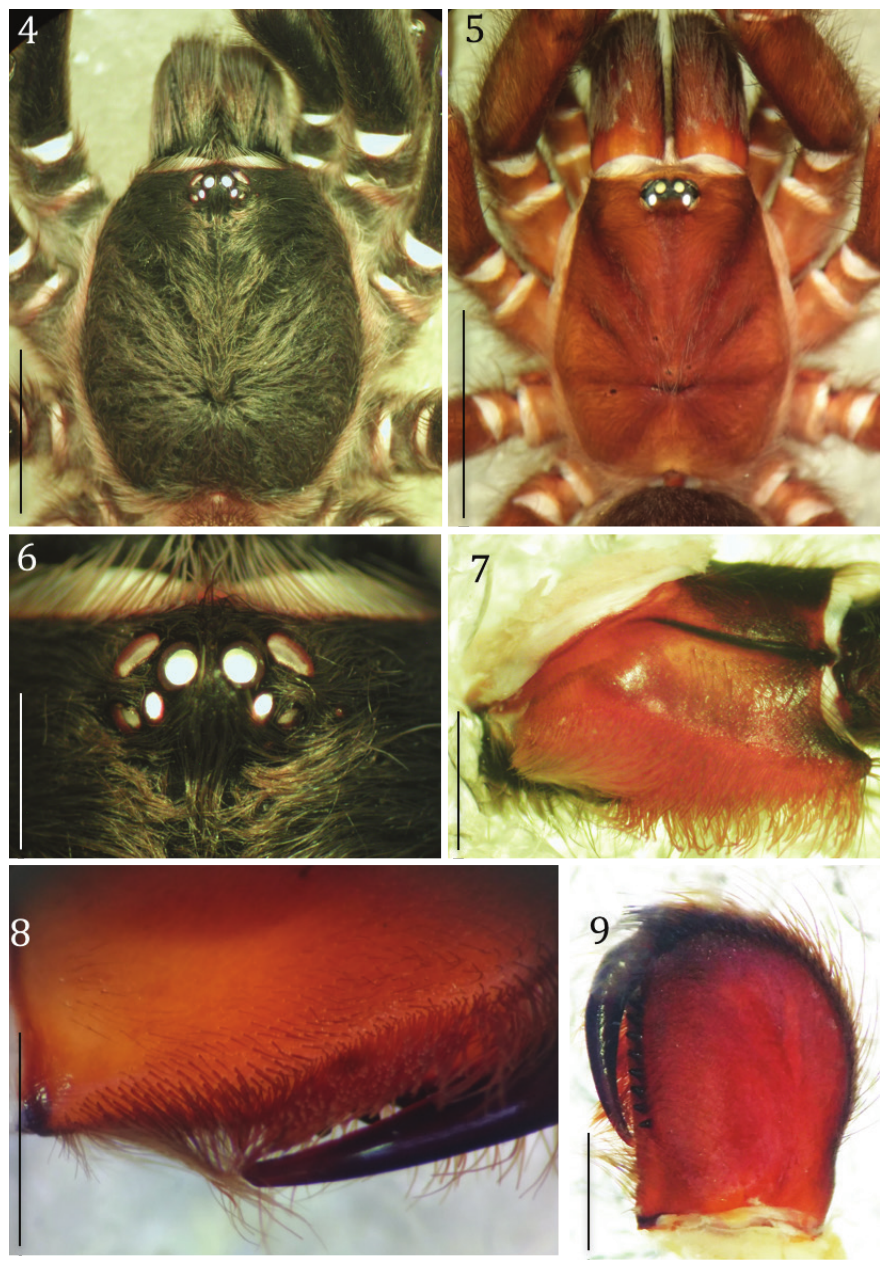
Figures 4–9. Phlogiellus longipalpus sp. n. 4, 6, 7 holotype ♂ , CUMZ-C2-NA1: 4 carapace, dorsal view 5 carapace, dorsal view, paratype ♀ , CUMZ-C4-NA4 6 eyes, dorsal view 7 left maxilla, prolateral view. 8, 9 paratype ♂ , CUMZ-C4-NA4: 8 chelicerae striker, retrolateral view 9 right chelicerae prolateral view. Scale bars: 4 mm ( 4–5 ); 1 mm ( 6–9